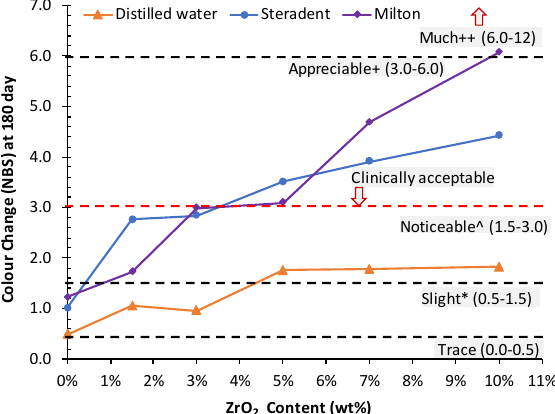
Figure 2. Line graph showing the colour change according to NBS unit system in specimens immersed in DW, Steradent (STD) and Milton (MIL) for 180 days.